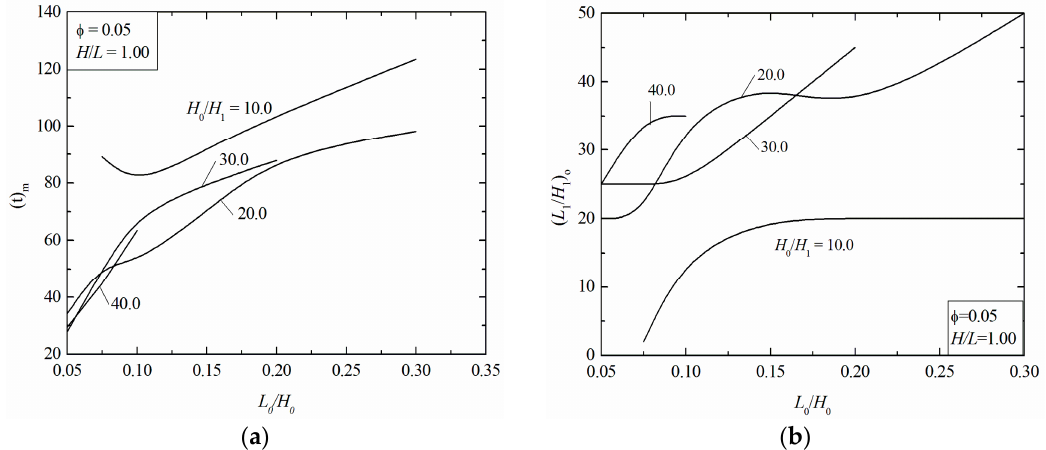
Figure 11. Effect of the ratio L 0 / H 0 for different ratios of H 0 / H 1 on ( a ) infusion time (once minimized), Figure 11. E ff ect of the ratio L 0 / H 0 for di ff erent ratios of H 0 / H 1 on ( a ) infusion time (once minimized), ( t ) m ; ( b ) ratio (once optimized), ( L 1 / H 1 ) o